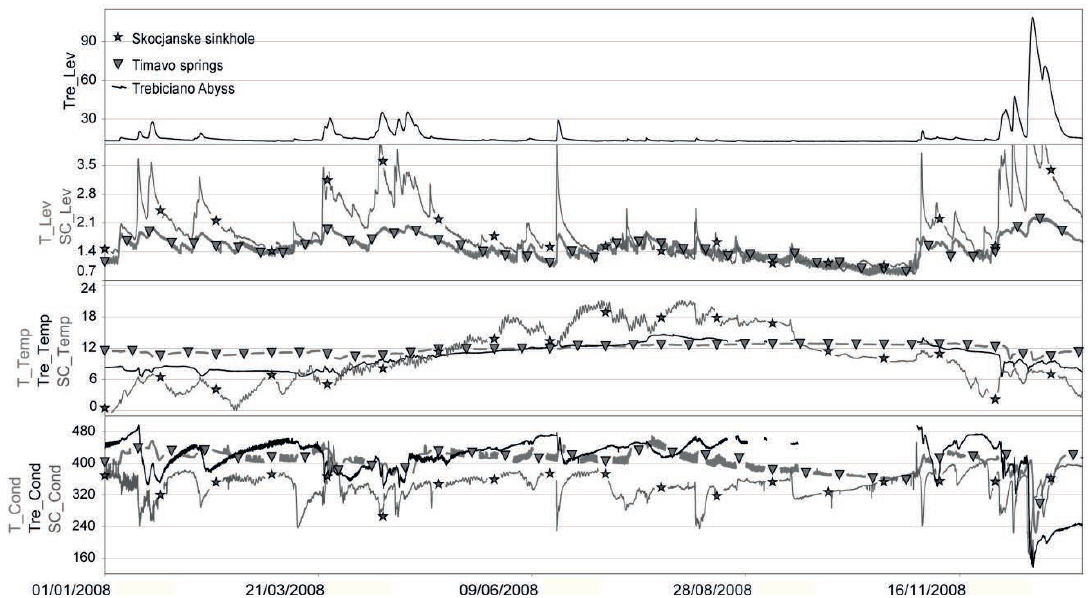
Fig. 2 Analysed data (year 2008: January–December) for the Škocjanske sinkhole, Trebiciano Abyss and Timavo spring. Represented parameters are water level (m a.s.l.), temperature (°C) and EC ( µ S/cm).